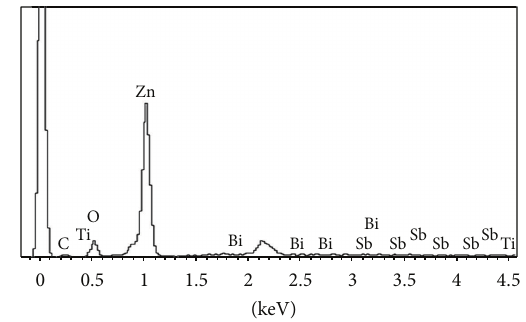
Figure 6: The EDX of etched validated varistor